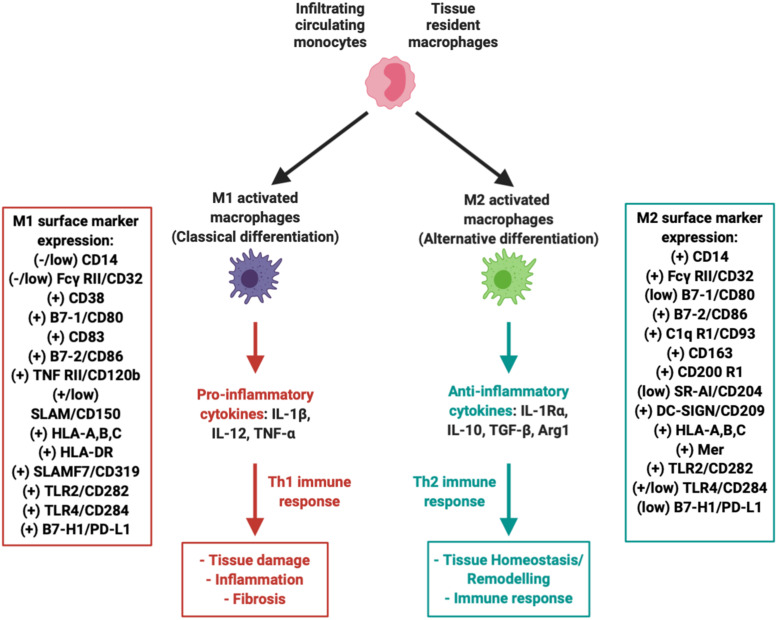
Macrophages within the IFP can polarize into M1 (pro-inflammatory) or M2 (anti-inflammatory, tissue repair) variants. Both variants are associated with a multitude of unique surface markers with varying levels of expression that allow for proper identification.